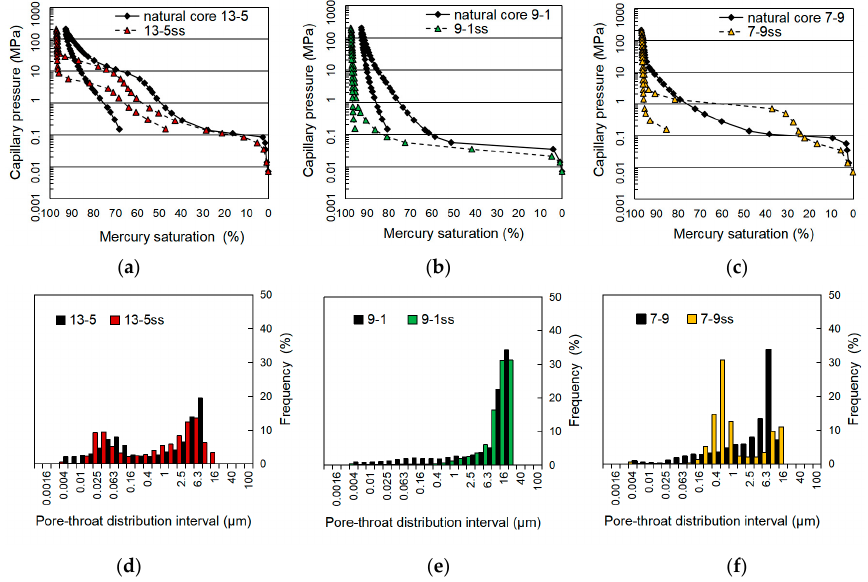
Figure 13. The comparison of the MICP ( a – c ) and the pore-throat distribution ( d – f ) results of the synthetic sandstone to the target. The solid lines in the top figures with ♦ are the MICP curves of the target natural cores of 9-1, 13-5, and 7-9. The color line in the top figures are the MICP curves of the synthetic sandstone counterpart. The figures at the bottom are the pore throat size distribution of the target samples shown in black compared to their synthetic sandstone counterpart in color.